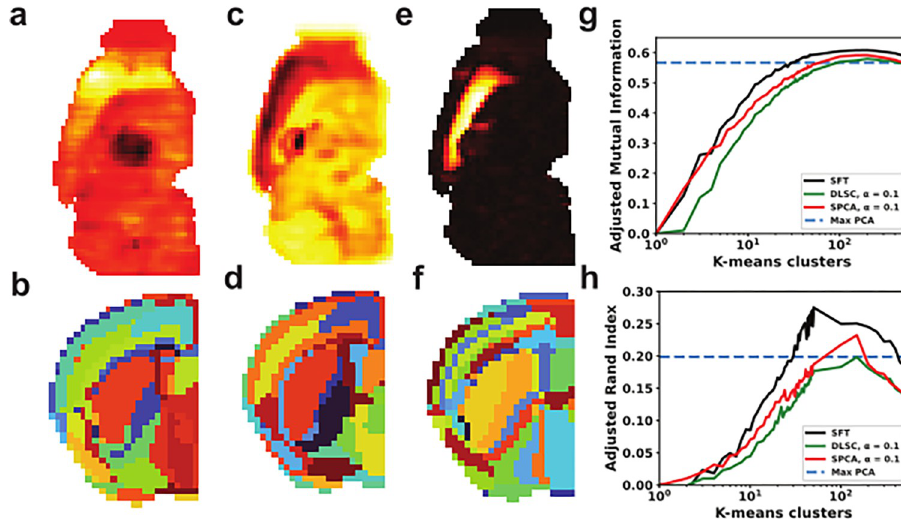
Fig 3. Sparse representations of AMBA. (a) DLSC representation, active in the cortex. (b) K-means clustering (K = 200) of DLSC representations in a coronal slice. (c) SPCA representation, chosen for similarity. (d) K-means clustering of SPCA representations. (e) SFt representation, active in the cortex. (f) K-means clustering of SFt components. (g, h) Adjusted Mutual Information and Adjusted Rand Index of clustered components using K-means clustering with K ranging from 1 to 50 and from 50 to 550 with a step of